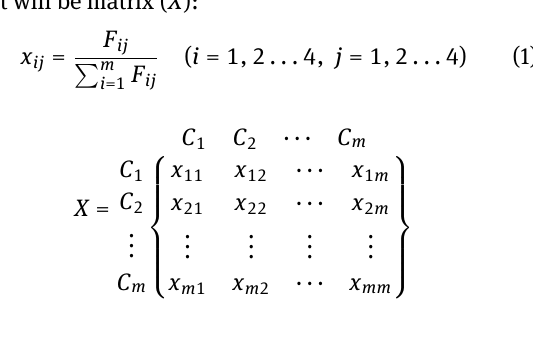
ing Table 8. Based on the number of the criteria used in AHP method, the random consistency index is de- termined. The consistency ratio (CR) is computed by dividing ( CI ) to (RC). If the consistency ratio (CR) is ≤ 0.1 ,the pair wise comparison matrix ( F ) is consid- ered to have an acceptable trust worthy and consis- tency; otherwise, it required to be revised